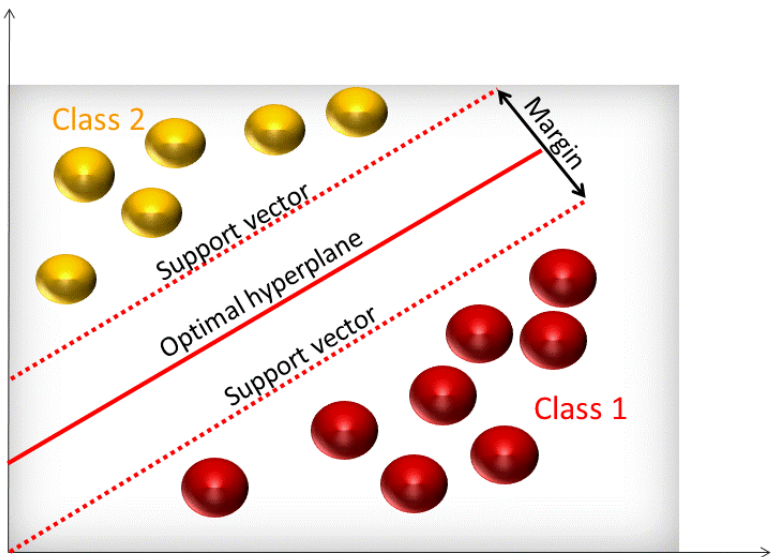
Figure 4. Representation of general classification hyperplane that maximizes the margin of the training data.